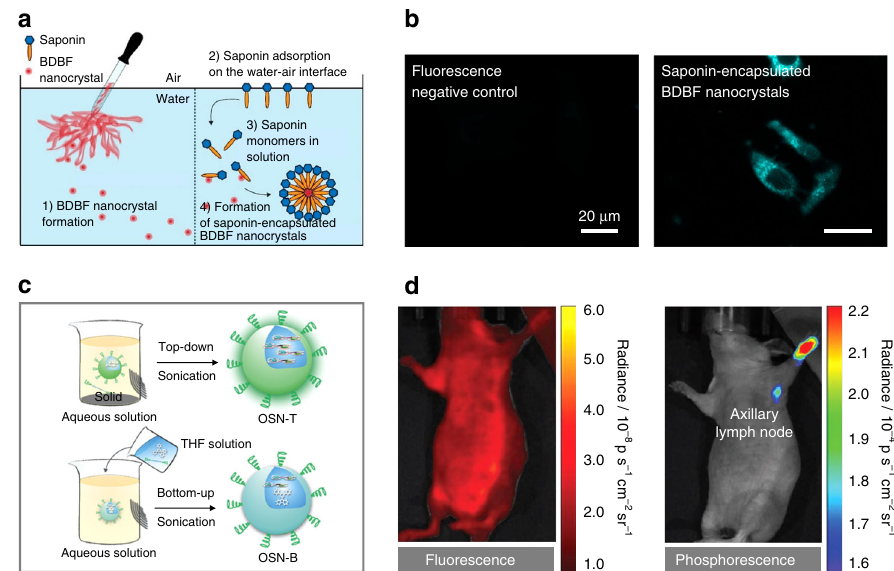
Fig. 6 Nanoencapsulation and surface functionalization of nanocrystals and amorphous nanoaggregates to yield organic RTP contrast agents for bioapplications. a Schematic illustration of the nanoencapsulation of BDBF RTP nanocrystals using saponin. b Confocal laser scanning microscopy images of HeLa cells treated with pure BDBF nanocrystals (left) and saponin-encapsulated BDBF nanocrystals (right). c Schematic illustration of the syntheses of amorphous organic semiconducting nanoparticles with ultralong RTP, i.e., OSN-T and OSN-B, using top-down (top) and bottom-up (down) approaches, respectively. d Fluorescence (left) and ultralong phosphorescence (right) imaging of lymph node in living mice using intradermally administered OSN-T. a and b are adapted with permission from ref. 58 . Copyright (2017) American Chemical Society. c and d are adapted with permission from ref. 59 .